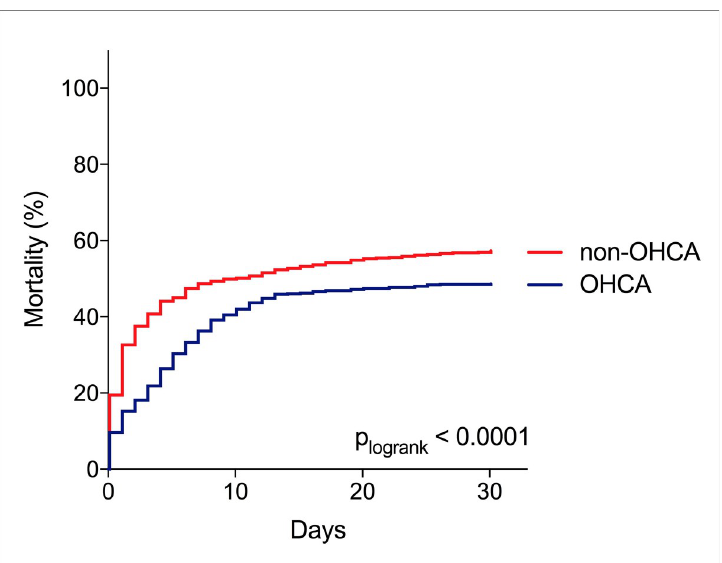
Fig 2. Kaplan Meier curves depicting 30-day mortality among the complete cohort (n = 1716) stratified into subgroups presenting with and without out-of-hospital cardiac arrest. OHCA: Out-of-hospital cardiac arrest.